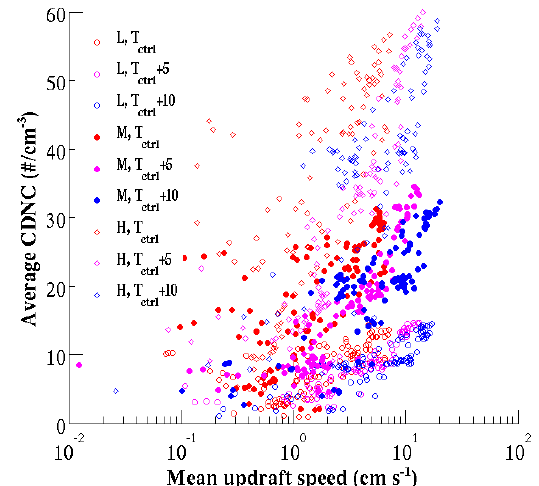
Figure 3. Correlation between domain and time averaged updraft speed ( W a ) and CDNC in the uniform temperature perturbation along the north–south transect of the domain. Average CDNC is calculated for positive mean vertical velocity ( W a > 0) in the corresponding grid box of the model. L, M and H in the legend stands for the ‘low’, ‘medium’, and ‘high’ aerosol cases,